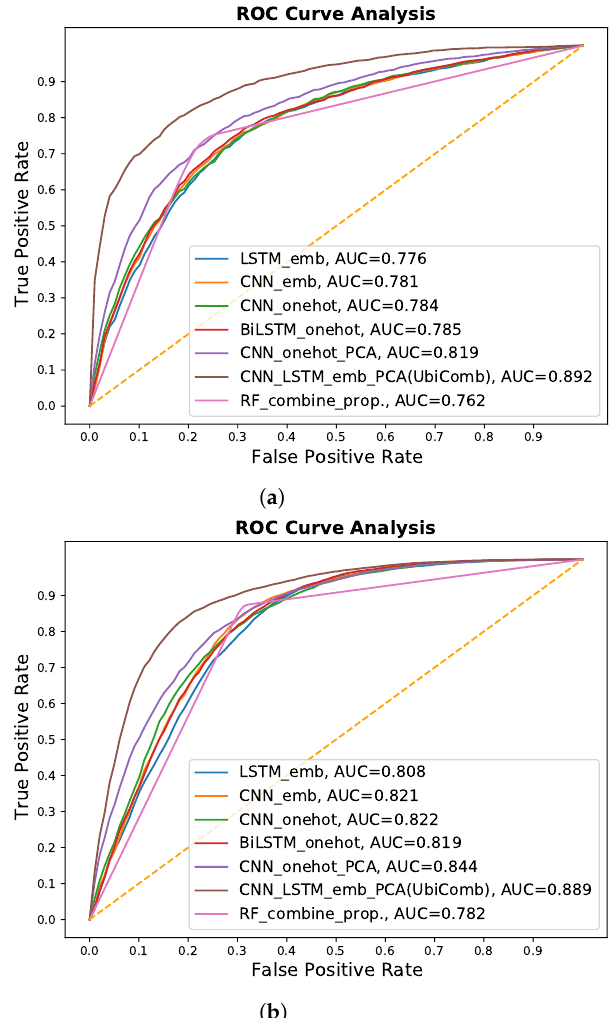
Figure 2. ROC-AUC comparisons of different techniques. ( a ) 10-fold cross validation. ( b ) Indepen- dent data